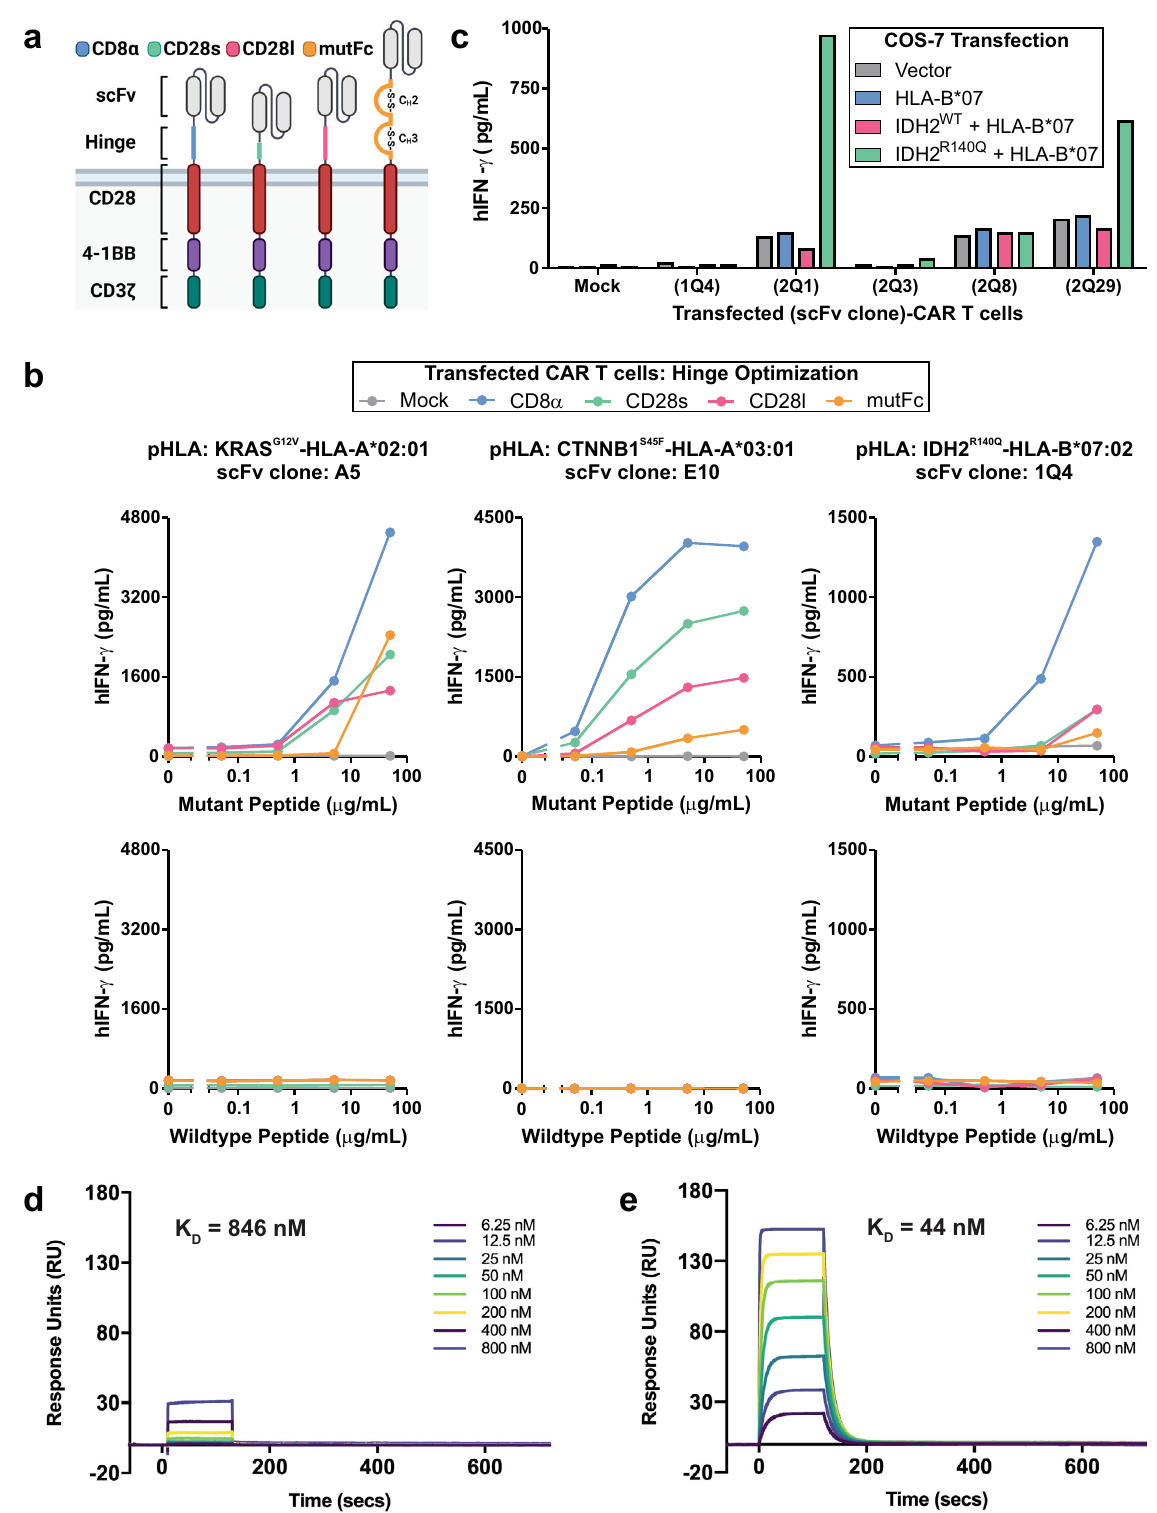
(Fc γ R) and reduce off-target CAR activation 62 . To determine whether a particular hinge would promote improved targeting properties across multiple HLA-restricted MANA targets, the four CAR hinges were tested in combination with three TCRm scFvs each targeting a unique mutant pHLA complex from three common HLA alleles: KRAS G12V -HLA-A * 02:01, β -catenin